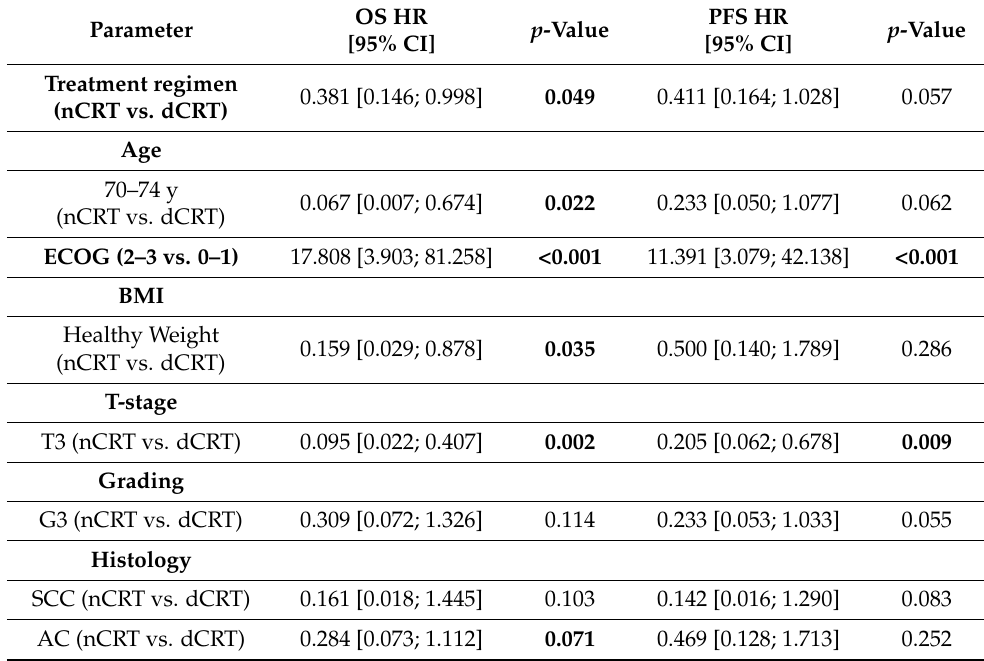
Table 5. Univariate Cox regression and subgroup